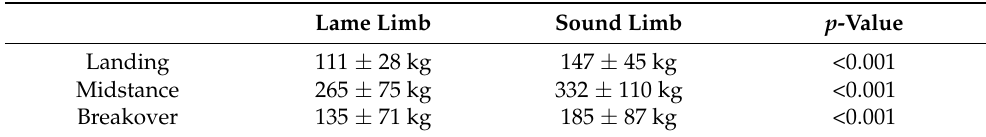
Table 4. Pairwise comparisons of the bilateral vertical force in kg between the sound and the lame limb before anaesthesia during landing, midstance, and